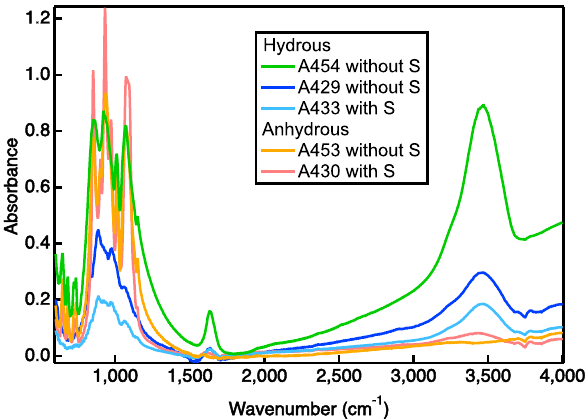
Figure 5. Infrared absorption spectra of recovered samples. The OH stretching bands at ~ 3450 cm −1 were observed only for the hydrous